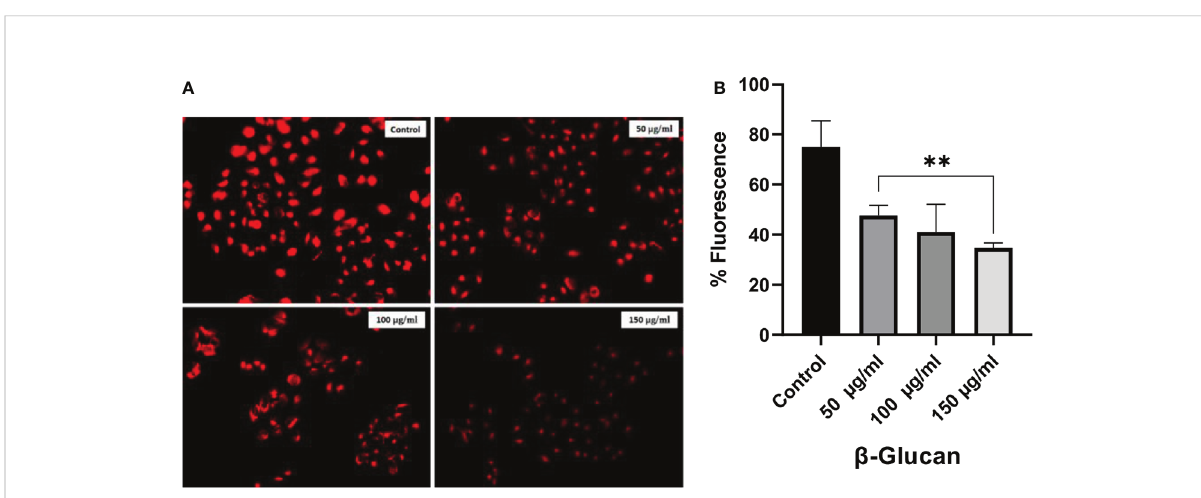
FIGURE 12 LysoTracker Red stained HeLa cells. (A) Red fl uorescence intensities of the HeLa cells were signi fi cantly decreased after exposure to 50, 100, and 150 m g/ml of concentration showing the decrease in number of acidic organelles with the increase in treatment. (B) One-way ANOVA was performed with the help of GraphPad Prism 8.0 software using GraphPad Prism showing 50, 100, and 150 m g/ml as signi fi cant with a p-value = 0.0012 (p < 0.05). Quantitative estimation performed with ImageJ software. *Least signi fi